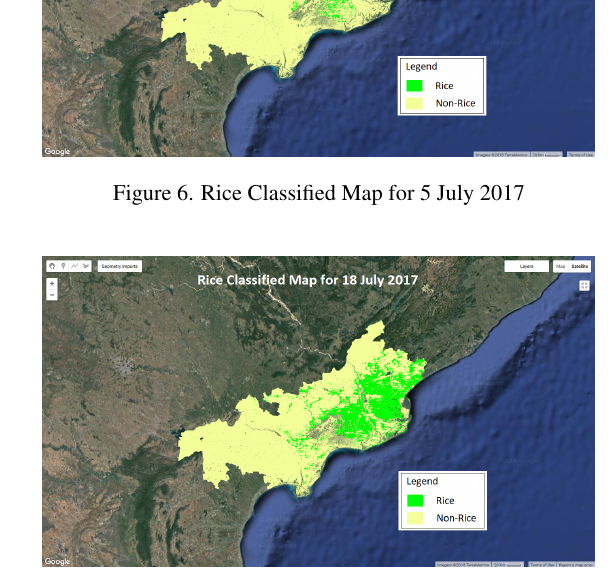
Figure 7. Rice Classified Map for 18 July 2017